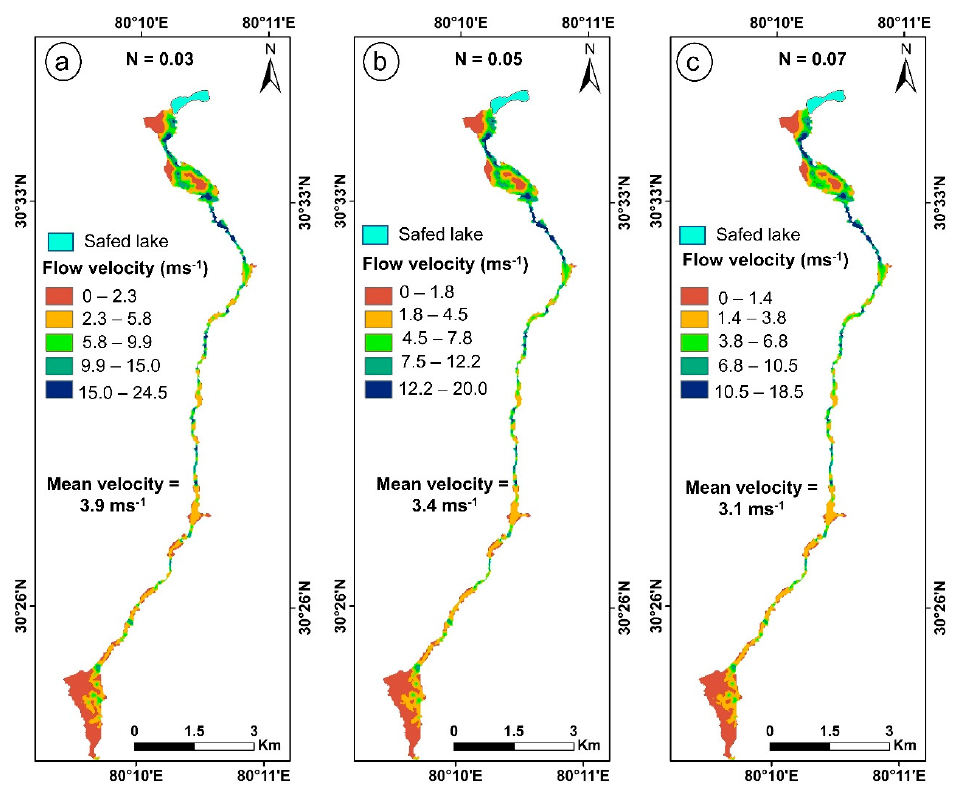
Figure 11. Spatial distribution of maximum flow velocity along the channel from Safed Lake to Milam village for varied Manning’s N—( a ) N = 0.03; ( b ) N = 0.05; ( c ) N =